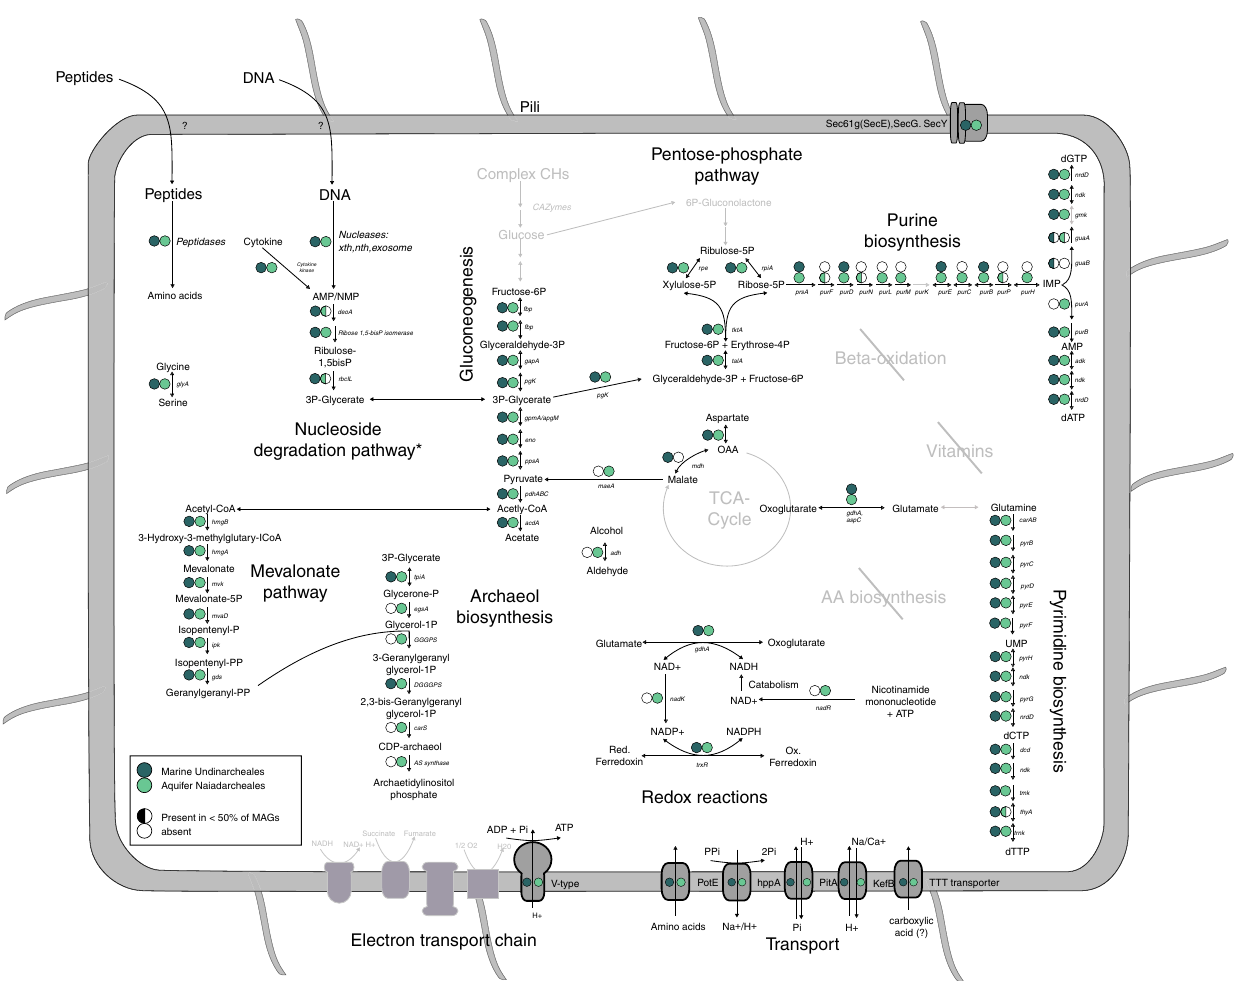
Fig. 2 Metabolic characteristics of Undinarchaeota projected on key pathways. Full circles: Gene of interest is present in all or more than 50% of genomes. Half circles: Gene of interest is present in less than 50% but found in at least one Undinarchaeota MAG. Open circle: Gene is absent in all Undinarchaeota MAGs. Dark green: MAGs belonging to the marine Undinarchaeales. Light green: MAGs belonging to the aquifer Naiadarchaeales. Grey: Missing genes/pathways. * deo A was only present in one Naiadarchaeales MAG and genes encoding RuBisCO were only found in two out of four Naiadarchaeales MAGs and it remains to be determined whether this is due to genome incompleteness or a sign of genome streamlining. A detailed list of genes encoded by Undinarchaeota can be found in Supplementary Data 7 –